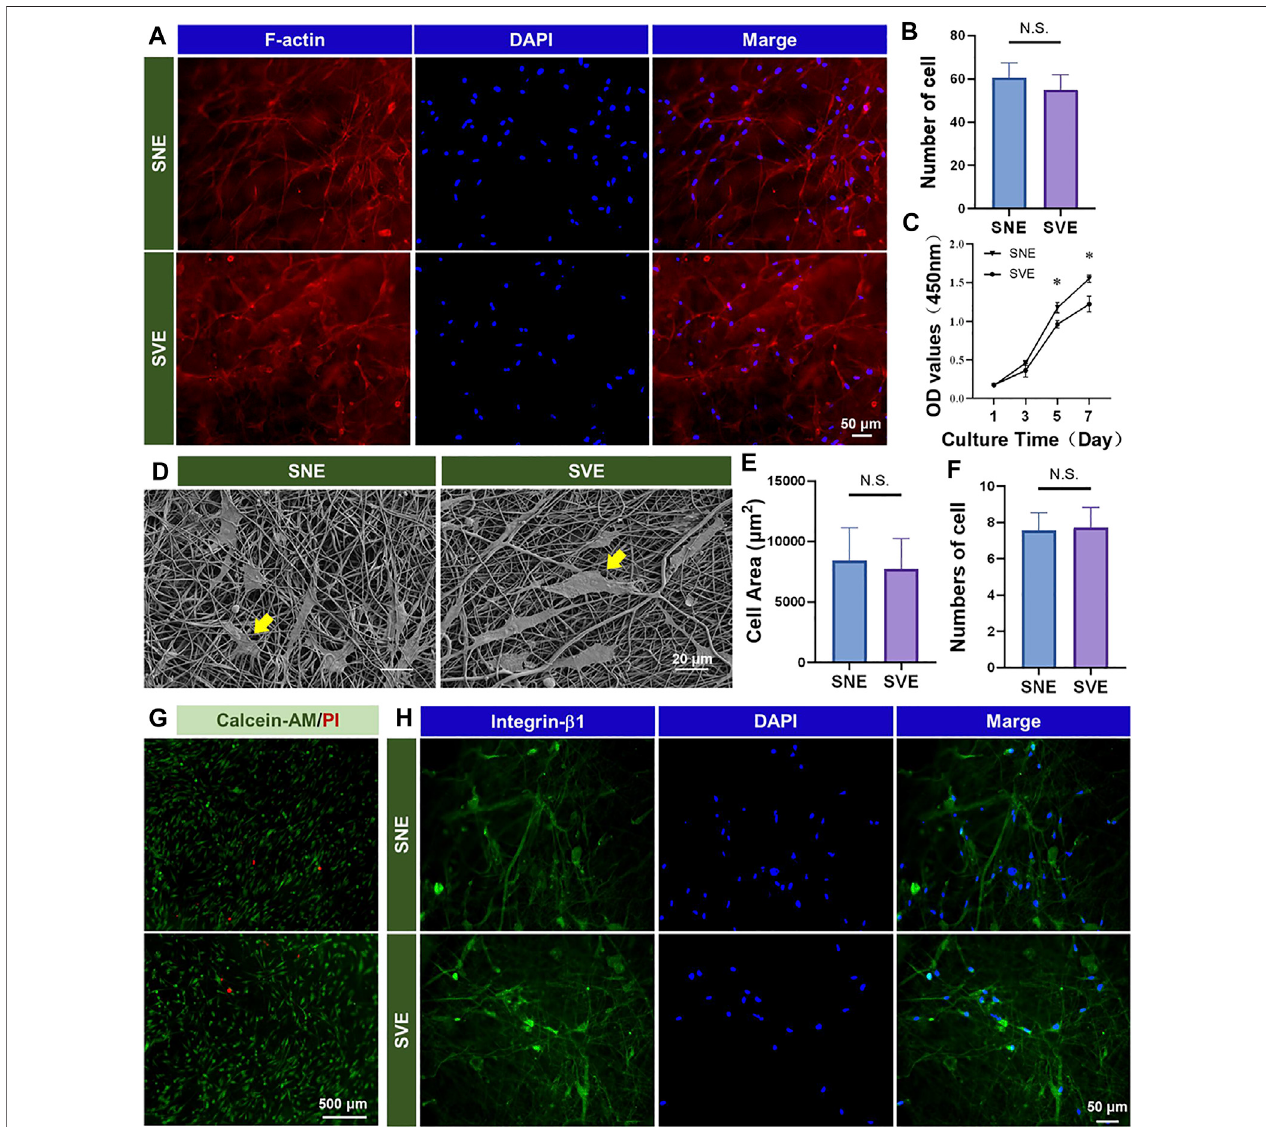
FIGURE3| Biocompatibility ofthePCL/Gelnano fi bers produced bySNEand SVE: (A,B) morphologyand quanti fi edcellnumber ofhADSCson differentsamples; (C) cell proliferation; (D – F) cellspreadingand quanti fi edspreadingareaand adheredcellnumber ondifferentsamples; (G) cell viability;and (H) expression ofintegrin- β 1 for cell – fi ber